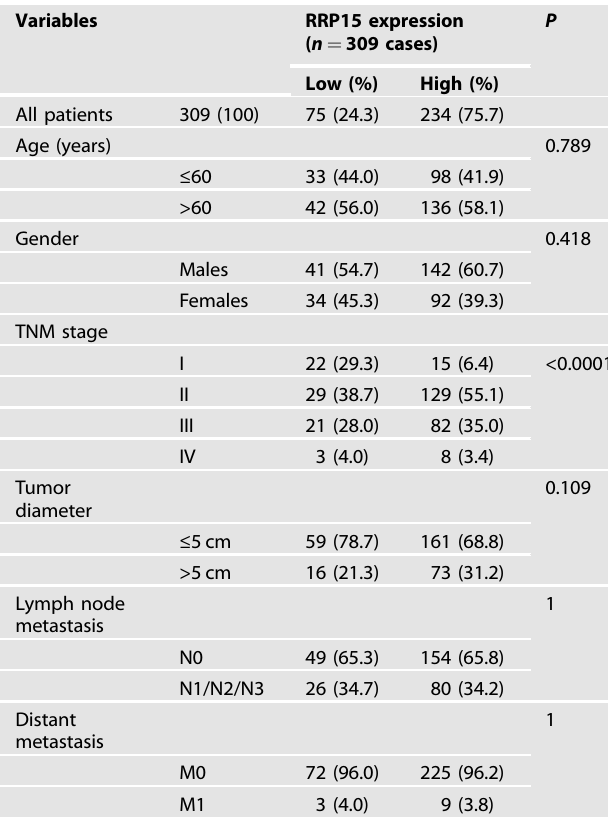
RESULTS RRP15 is upregulated and predicts poor survival in CRC